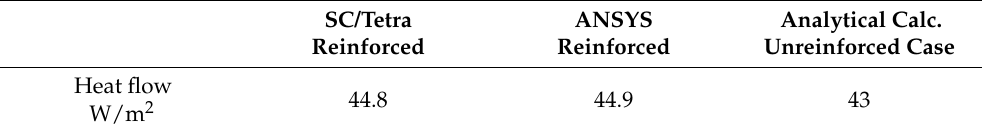
Table 5. Comparison of the measured and simulated values.